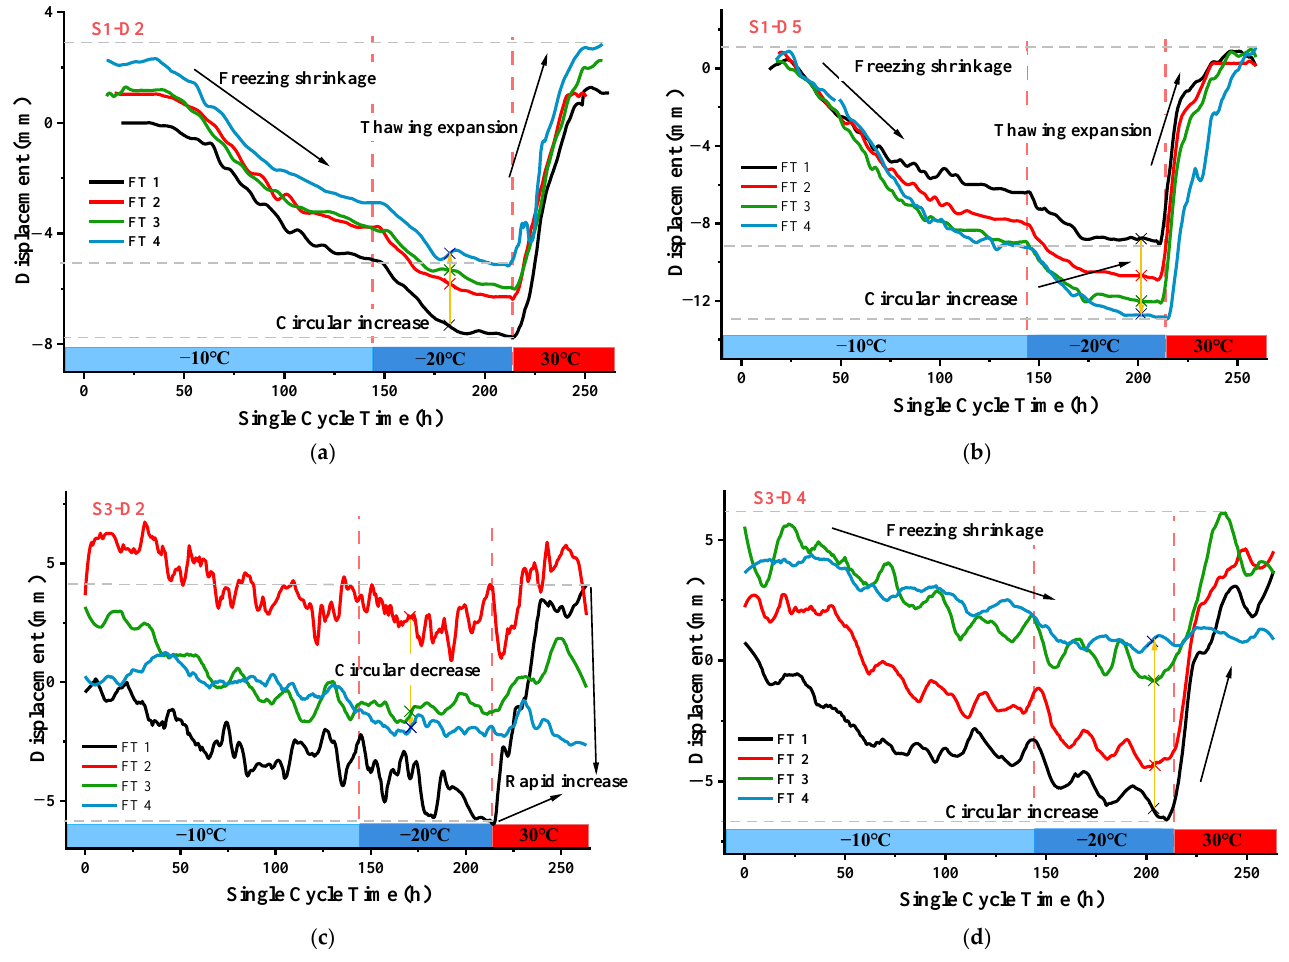
Figure 11. Displacement of the expansive soil slope model in four freeze – thaw cycles. ( a ) S1-D2; ( b ) S2-D5; ( c ) S3-D2; ( d ) S3-D4.